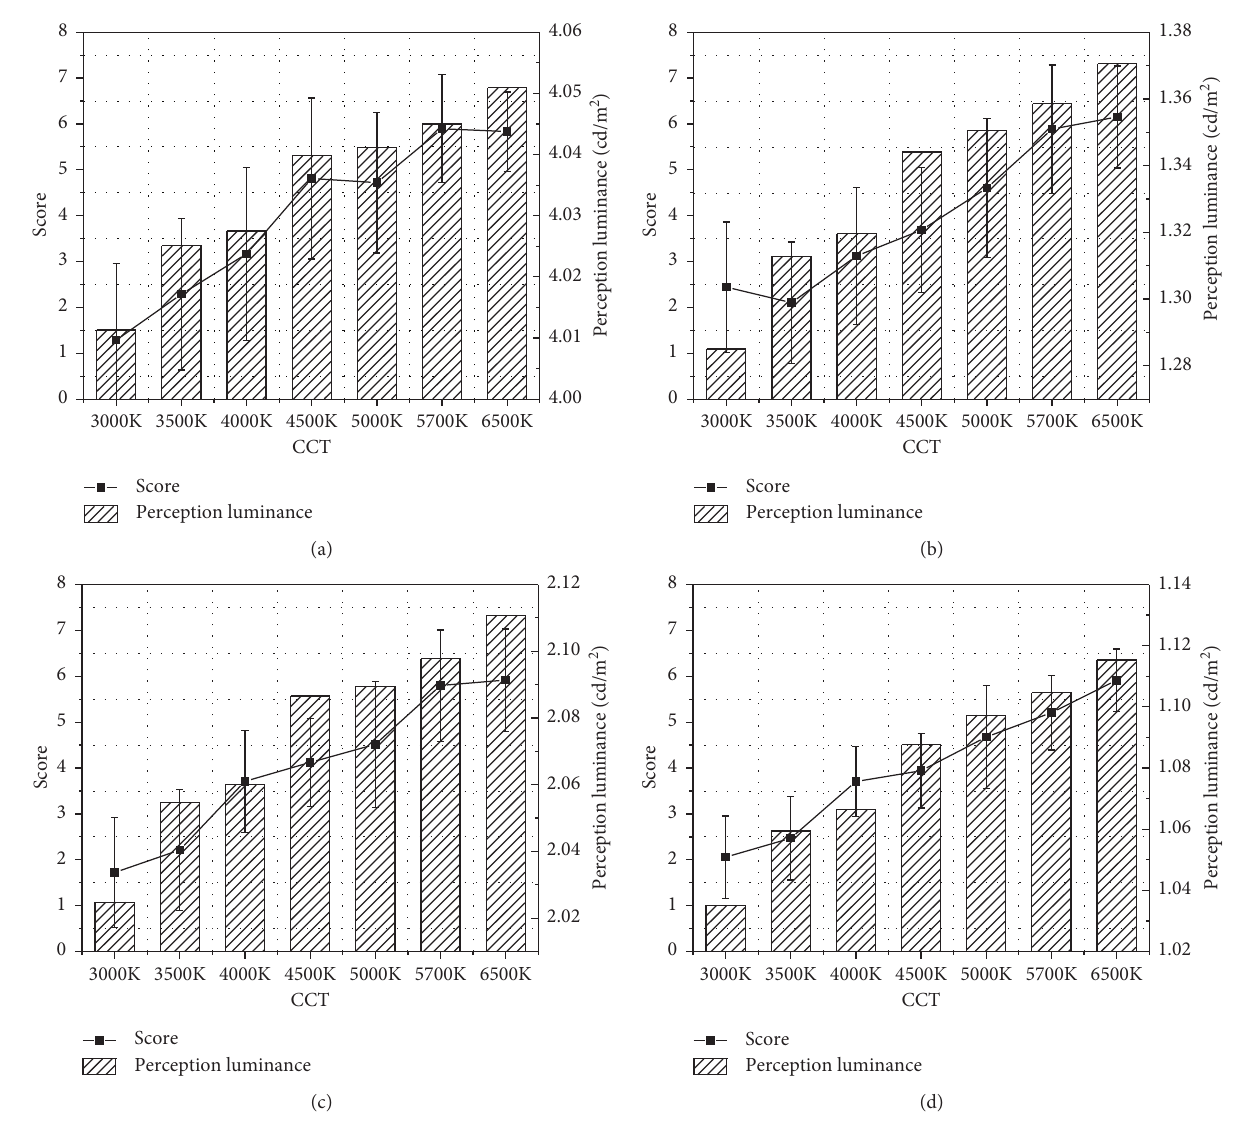
Figure 16: The Y -axis on the left shows the levels of visual clarity using different CCTs under different fog concentrations and illuminance without fog. The Y -axis on the right shows the theoretical calculation results of L f . (a) T � 100%, L i � 40l x . (b) T � 60%, L i � 20l x . (c) T � 100%, L i � 20l x . (d) T � 40%, L i � 20l x . Error bars indicate standard